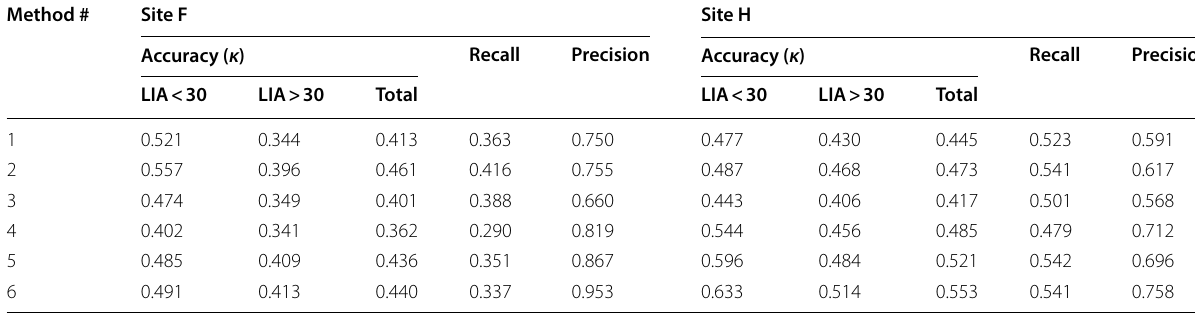
Table 3 Accuracies of landslide detection based on empirical rules applied to PALSAR-2 data Method #